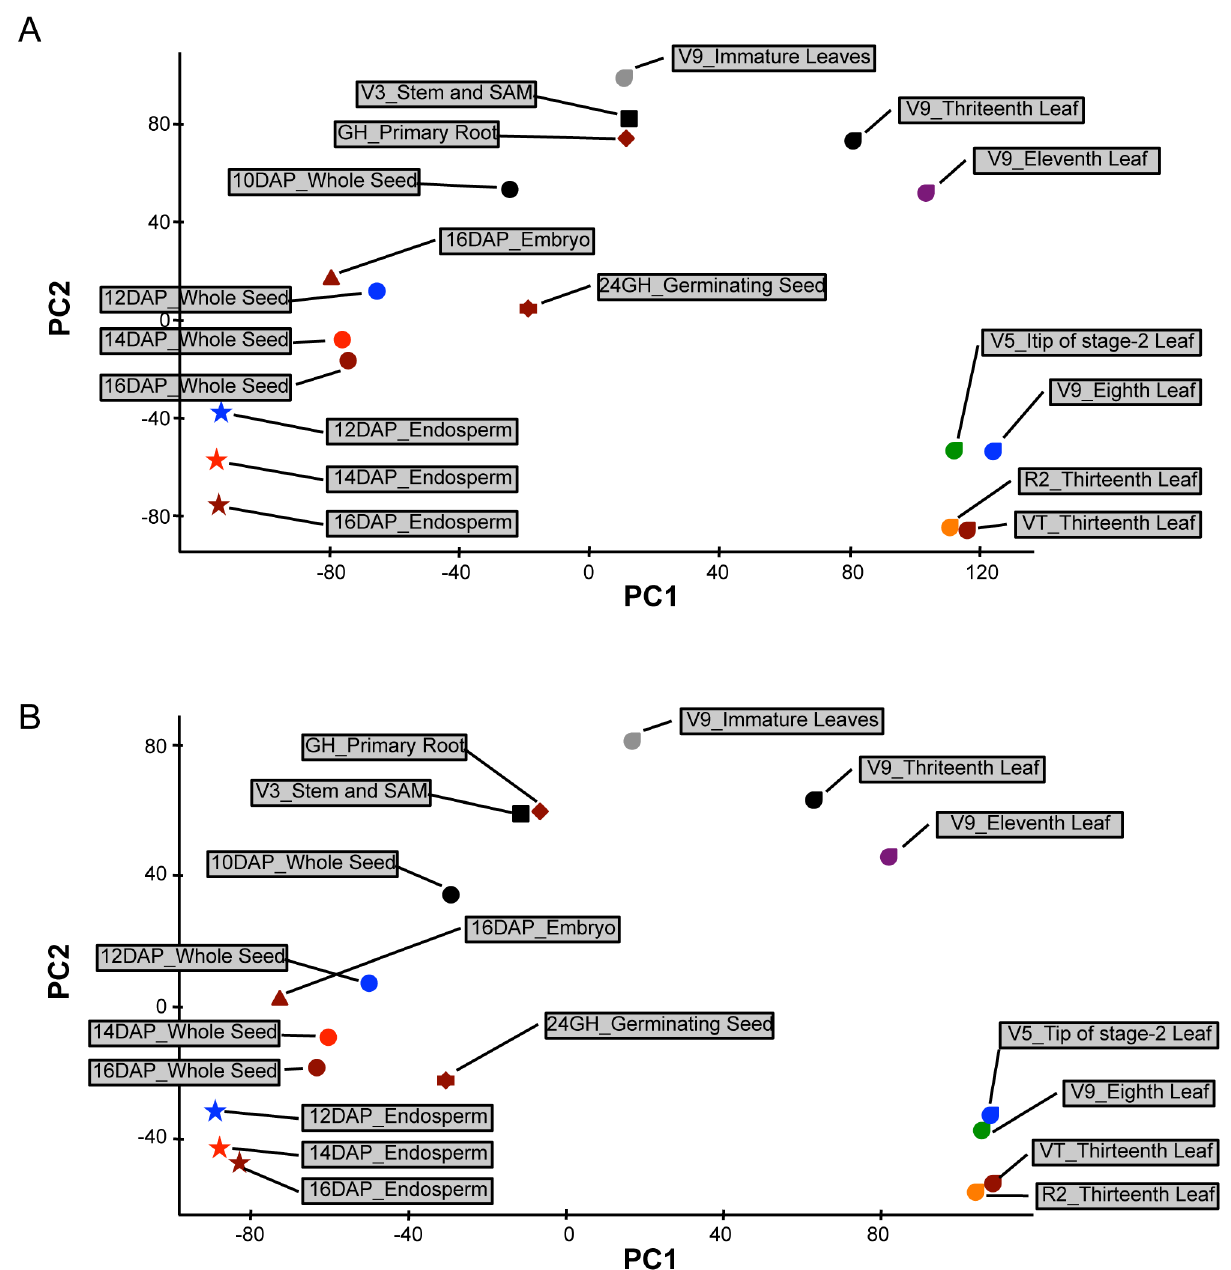
Figure 2. Principal Component Analysis (PCA) showing similarities between transcriptome profiles produced by RNA-Seq (A) and microarray (B). PCA was performed independently for both datasets. First principal component (PC1) is shown on x-axis while the second principal component (PC2) is shown on y-axis. Tissues belonging to same organ group are represented by different colors of the same shape.